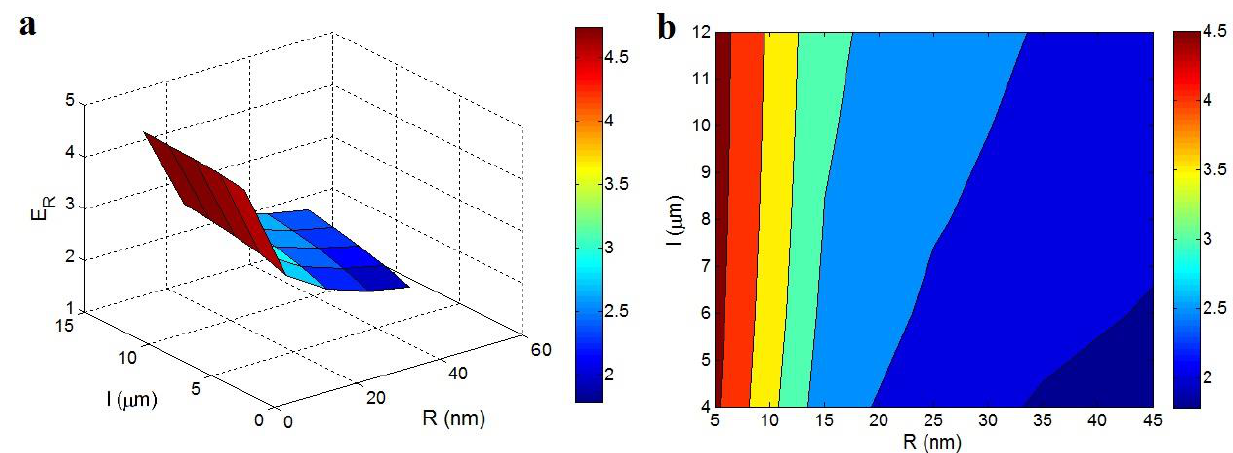
Figure 3. ( a ) The 3D and ( b ) contour plans of the influences of R and l on the relative modulus as predicted by the advanced model when E m = 2 GPa, ϕ f = 0.02, E f = 1000 GPa, E i = 100 GPa and t = 10 nm.